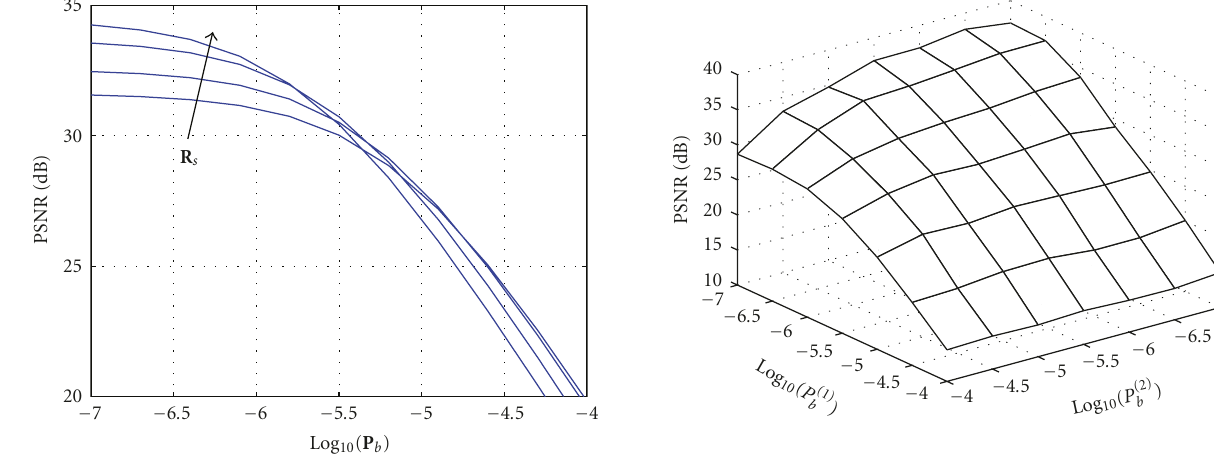
Figure 5: Typical universal rate-distortion characteristics PSNR ( R (1) s , R (2) s , P (1) b , P (2) b ) for a 2-layer SNR scalable H.263+ coder, for quantization parameters (QP I ,QP P ,QP Enh ) =